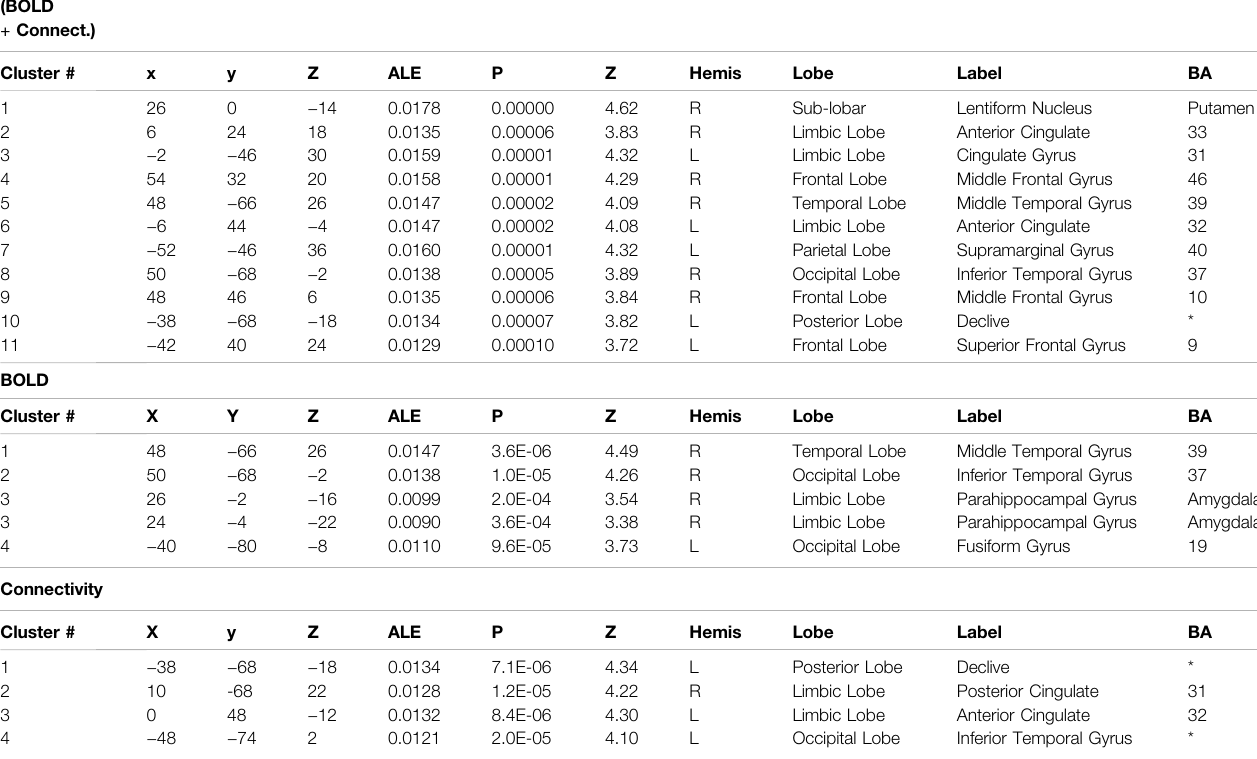
TABLE2|Overlapinbrainactivationacrossstudies ,asassessedusingaquantitativemeta-analysisofBOLDandconnectivitystudies.Themajoractivationsareshown with their corresponding Brodmann Area (BA), the ALE value of the peak activated voxel and MNI coordinates. Statistical values are also reported for each cluster. fMRI (BOLD +